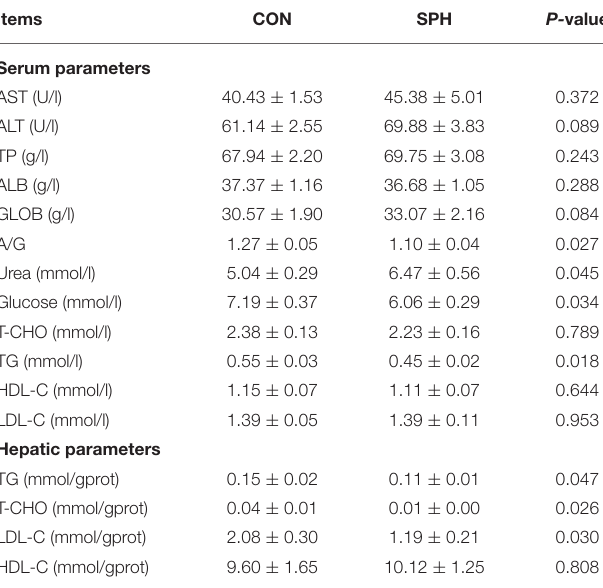
TABLE 1 | Serum and hepatic parameters in the CON and SPH groups. Items CON SPH P- value Serum parameters